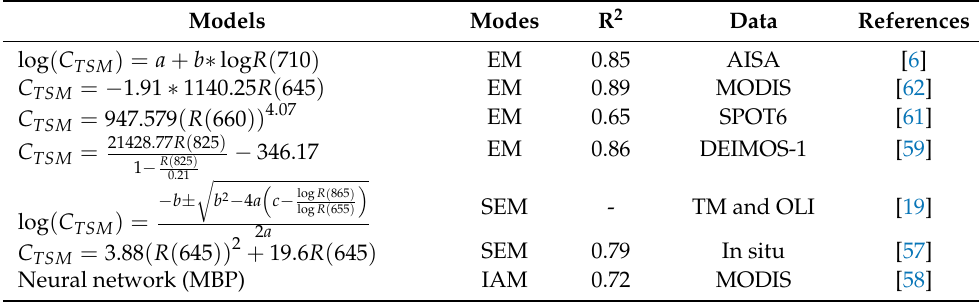
Table 2. Retrieval models of total suspended matter concentration (TSM).